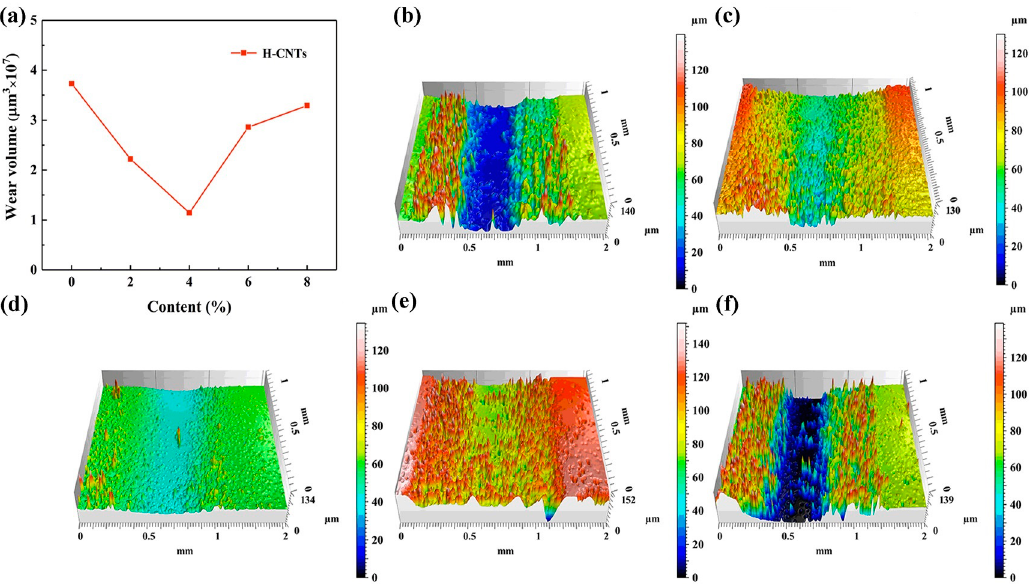
Figure 8. Wear volume curves and 3D wear profile of the original epoxy resin and the epoxy resin composites with different H-CNT contents. ( a ) Wear volume curve, ( b ) 0% H-CNTs, ( c ) 2% H-CNTs,